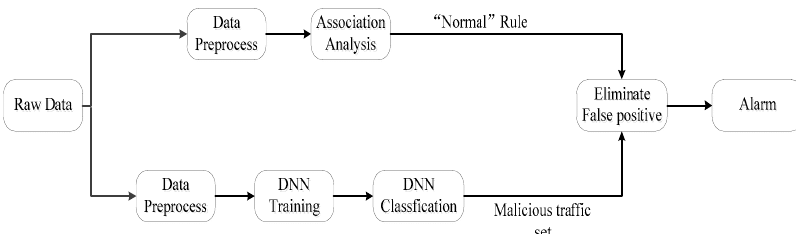
Figure 1. The process of our anomaly detection system, which mainly consists of preprocessing the dataset, deep neural network (DNN) training, classification, and association analysis.